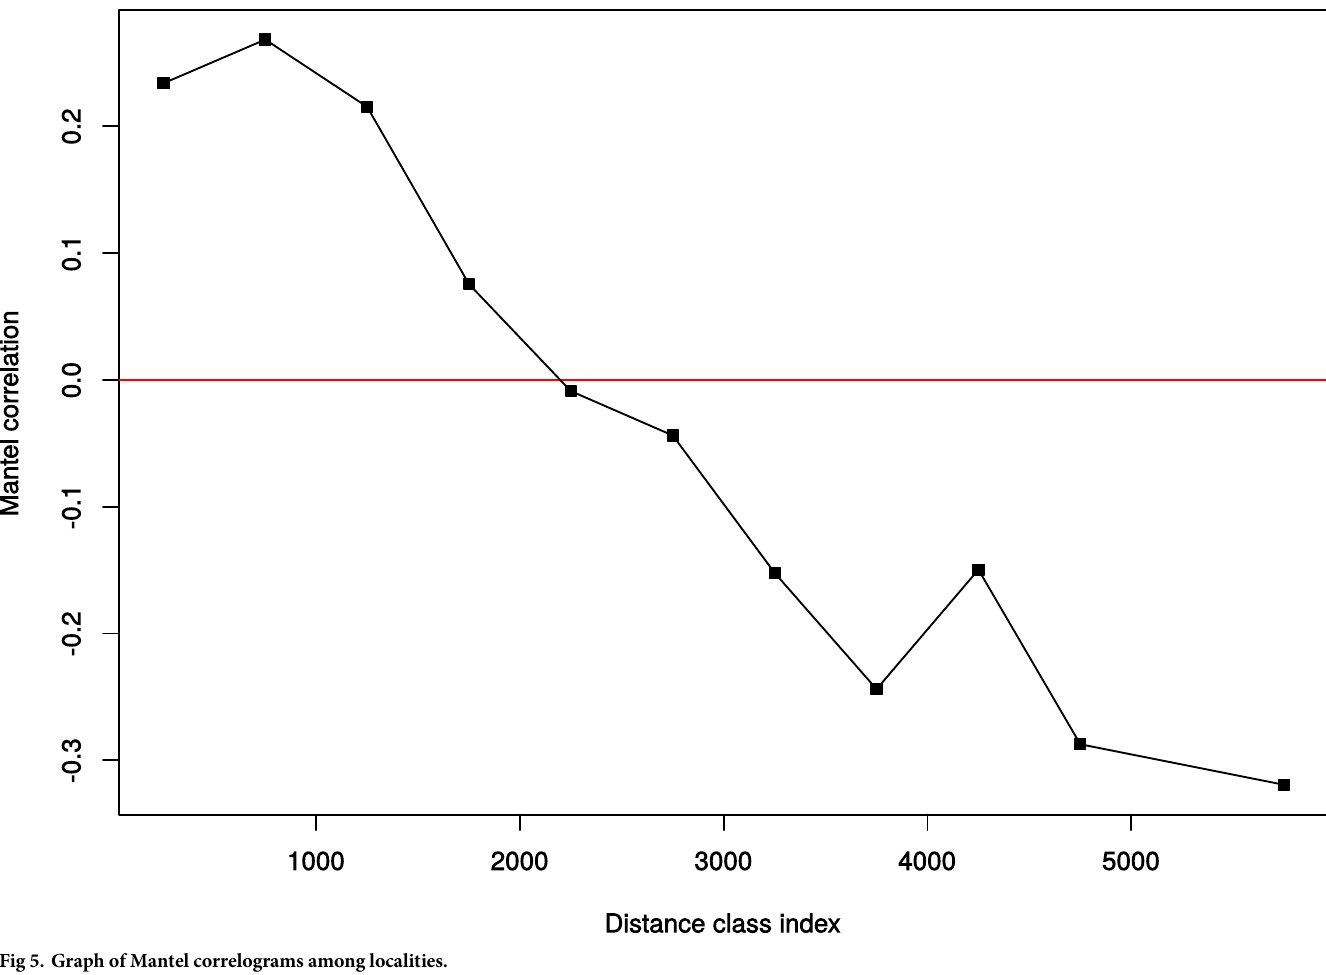
Fig 5. Graph of Mantel correlograms among localities.